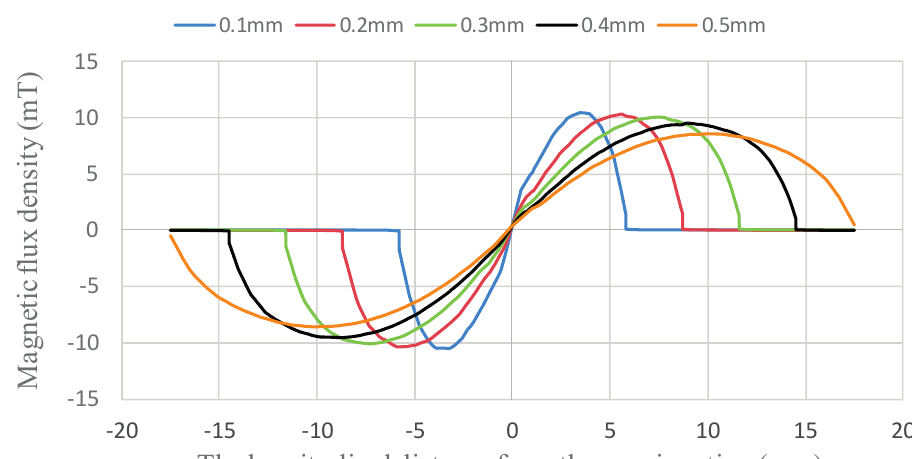
Figure 4. The theoretical magnetic flux density along the magnetic core vs. the distance from the core junction with respect to various wire width.